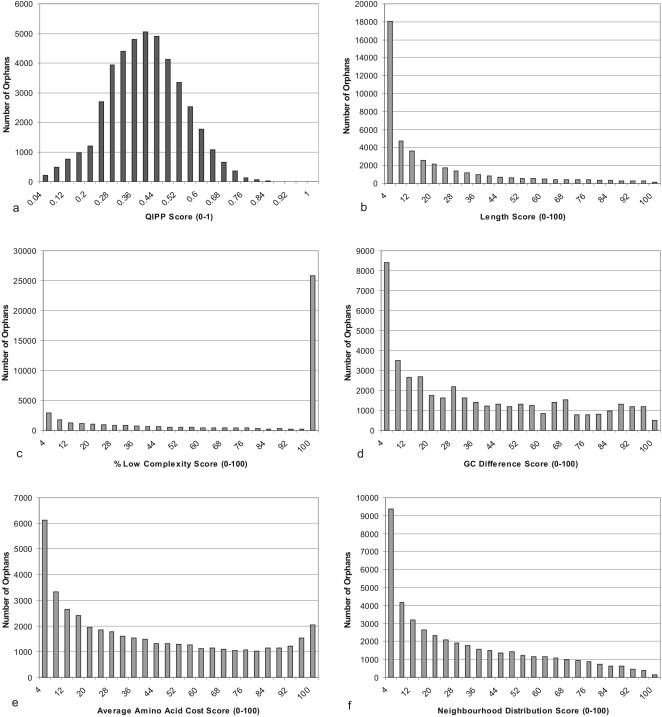
QIPP and Criterion Distributions of orphans in 122 bacterial genomes.The orphans (n = 43513) obtained from 122 bacterial genomes were scored and the distribution plotted according to (a) QIPP and the individual criteria that constitute QIPP: (b) length, (c) percent low complexity, (d) G+C difference from the mean, (e) cost and (f) Neighbourhood Distribution.